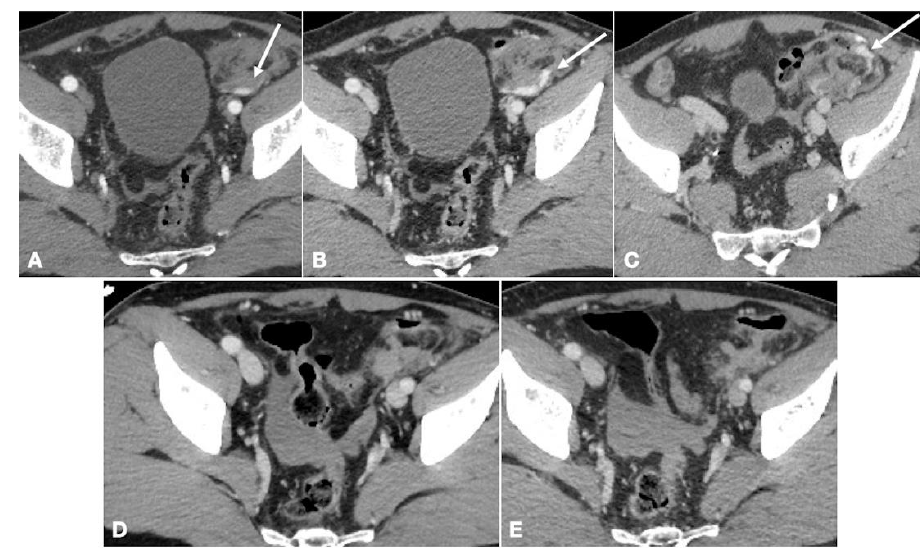
Figure 3. Enhanced-CT of a 54-year old male involved in major trauma (car accident). The multiphasic CT study allowed characterization of bleeding as arterial in origin, as seen on the arterial phase ( A , arrow). Contrast extravasation persisted in the subsequent two phases ( B , C , arrows). The patient then underwent angiography and embolization with absorbable material. Follow-up CT performed at 1st ( D ) and 4th ( E ) day after embolization showed no signs of bowel wall necrosis.